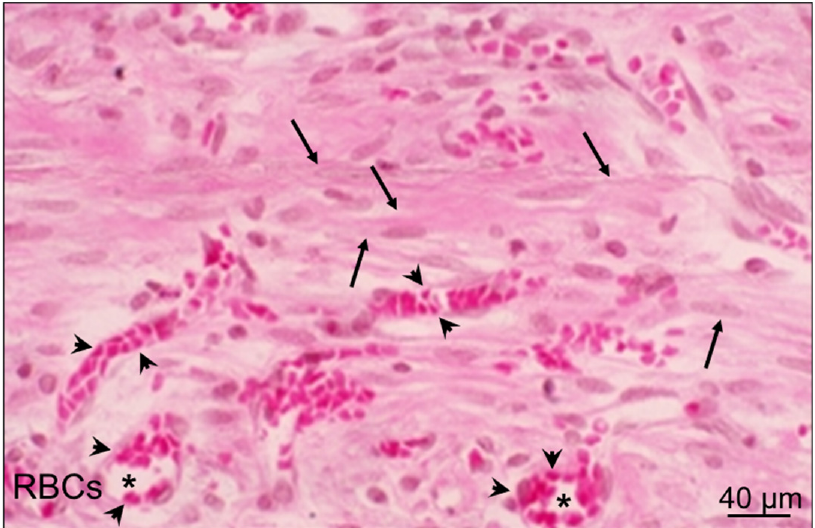
Figure 9. The granulation tissue at the ulcer base is the connective tissue component. This structure consists of fibroblasts, myofibroblasts (arrows), macrophages, and proliferating endothelial cells, forming blood vessels and microvessels (*) filled with erythrocytes (RBCs; arrowheads).